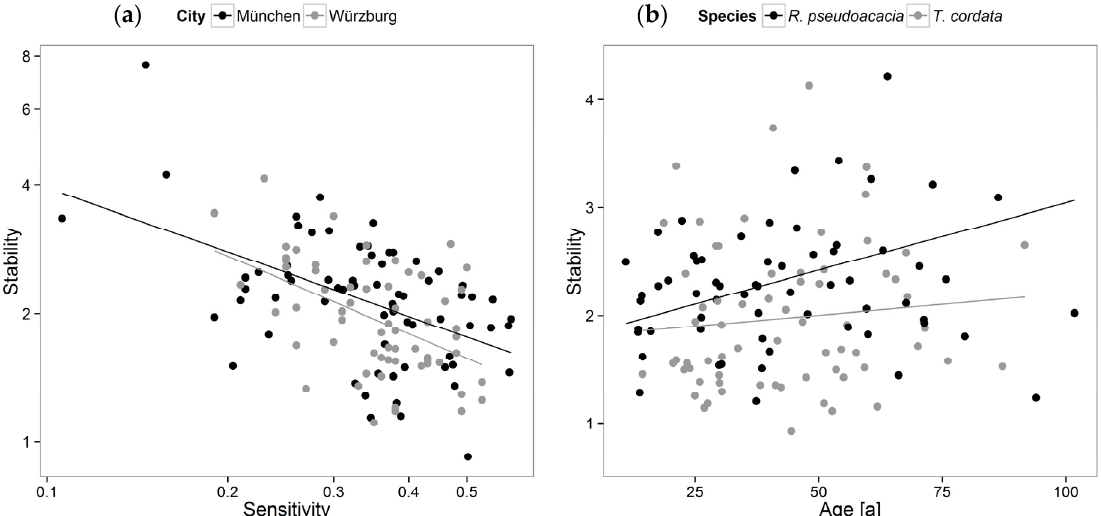
Figure 4. Regressions of stability with sensitivity ( a ) and stability with age ( b ). Highlighted are the regression lines of trees in München and Würzburg (a, ln(Stability) = 0.18 – 0.53 × ln(Sensitivity) – 0.08 × “City” + ε ), and Tilia cordata as well as Robinia pseudoacacia (b, Sensitivity = 1.57 + 0.01 × age + 0.36 × “Species” + ε ). For the regression of stability with sensitivity (b), both variables were log transformed.